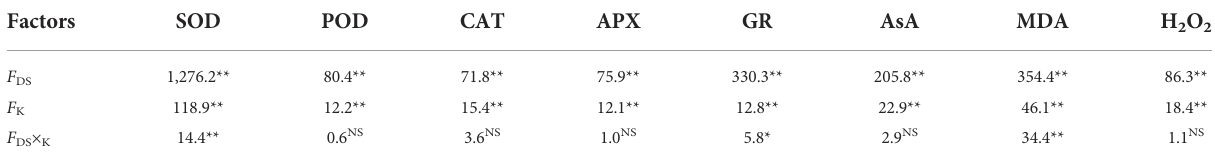
TABLE 2 Two-way ANOVA showing the signi fi cant effects of drought stress (DS), potassium (K), and their interactions on ROS metabolism-related traits in sesame leaf. Factors SOD